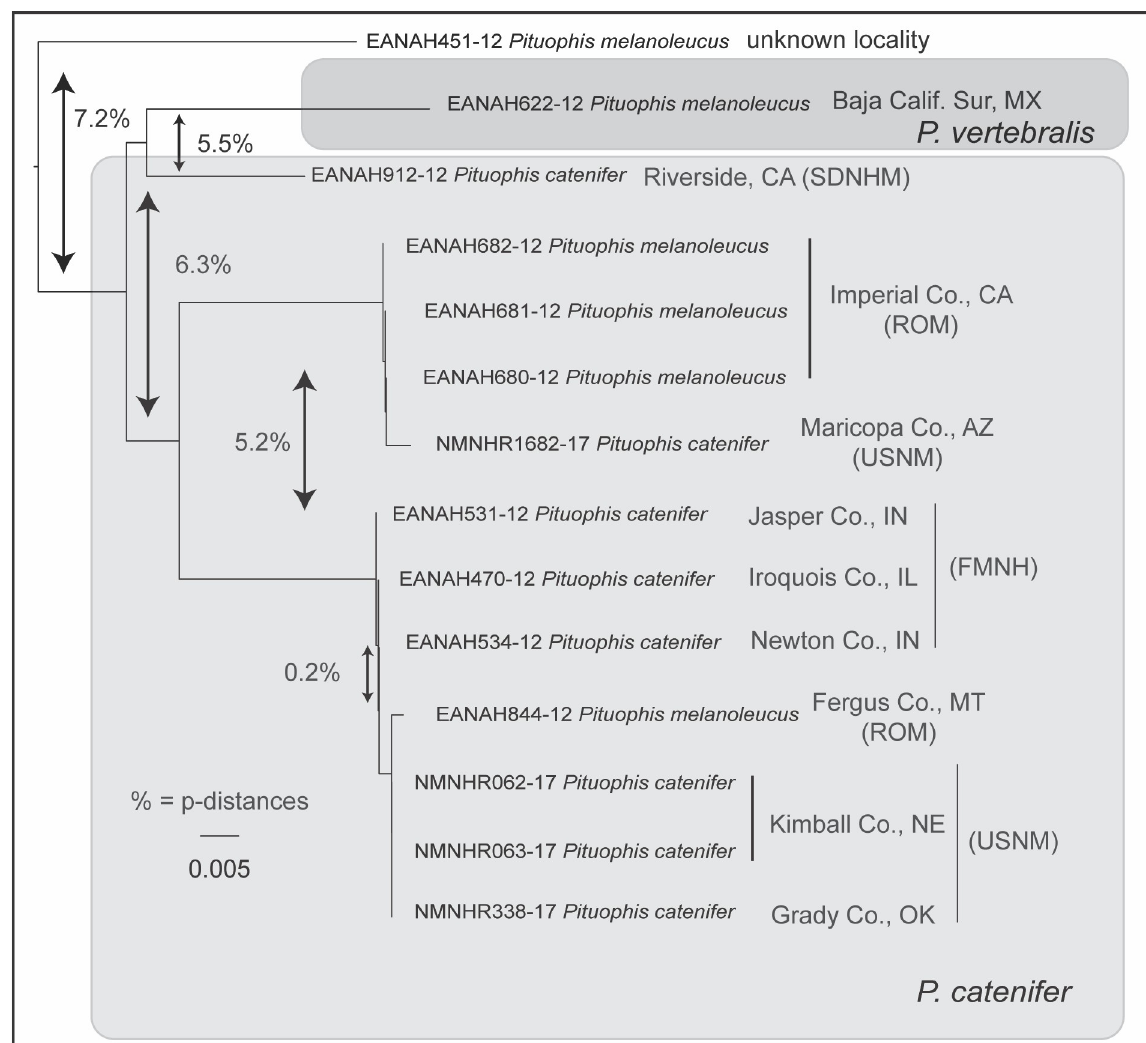
Fig 3. Neighbor-joining tree of Pituophis snakes, including samples from this study and another project in BOLD. Samples from our study begin with NMNHR, specimens from Chambers and Hebert [41] begin with EANAH and included outdated names from lending institutions. In that study, samples borrowed from the Field Museum of Natural History (FMNH) and San Diego Natural History Museum (SDNMH) had updated taxonomies that separate P . catenifer and P . vertebralis from P . melanoleucus , whereas the Royal Ontario Museum (ROM) did not. The researchers published the sequences in BOLD and GenBank using the outdated taxonomy and reported overall low levels of interspecific and high levels of intraspecific genetic divergences in their study on amphibians and reptiles, with similar mis-labelled individuals throughout [41]. While the wide-ranging P . catenifer does show high levels of intraspecific divergence (6.3%), adopting the current taxonomy (at that time) would have eliminated the erroneous detection of low levels of interspecific variation and provided more accurate estimates of intraspecific variation. Average uncorrected p-distances are shown between clades or samples indicated by arrows. Specimens are presented by BOLD Process IDs, followed by the species names adopted by the lending institutions at the time of the study, with some using the updated taxonomy and others not. Grey boxes indicate updated taxonomy. Sample EANAH451-12 presumably represents true P . melanoleucus ; however, no locality information was provided for that specimen.